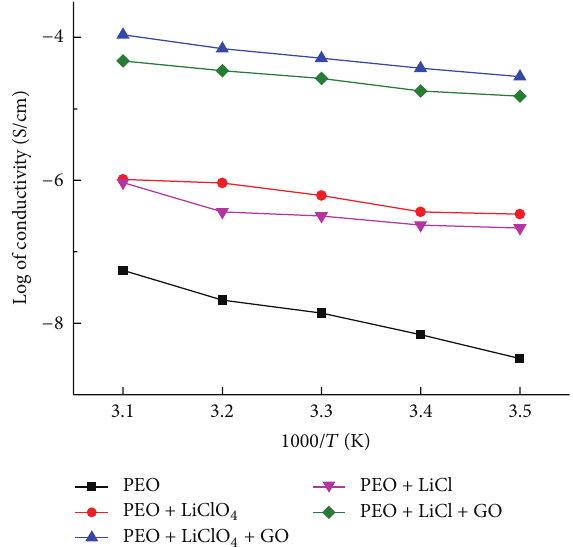
Figure 1: Conductance plot for PEO, PEO-LiClO 4 , PEO-LiCl, PEO- LiClO 4 -GO, and PEO-LiCl-GO